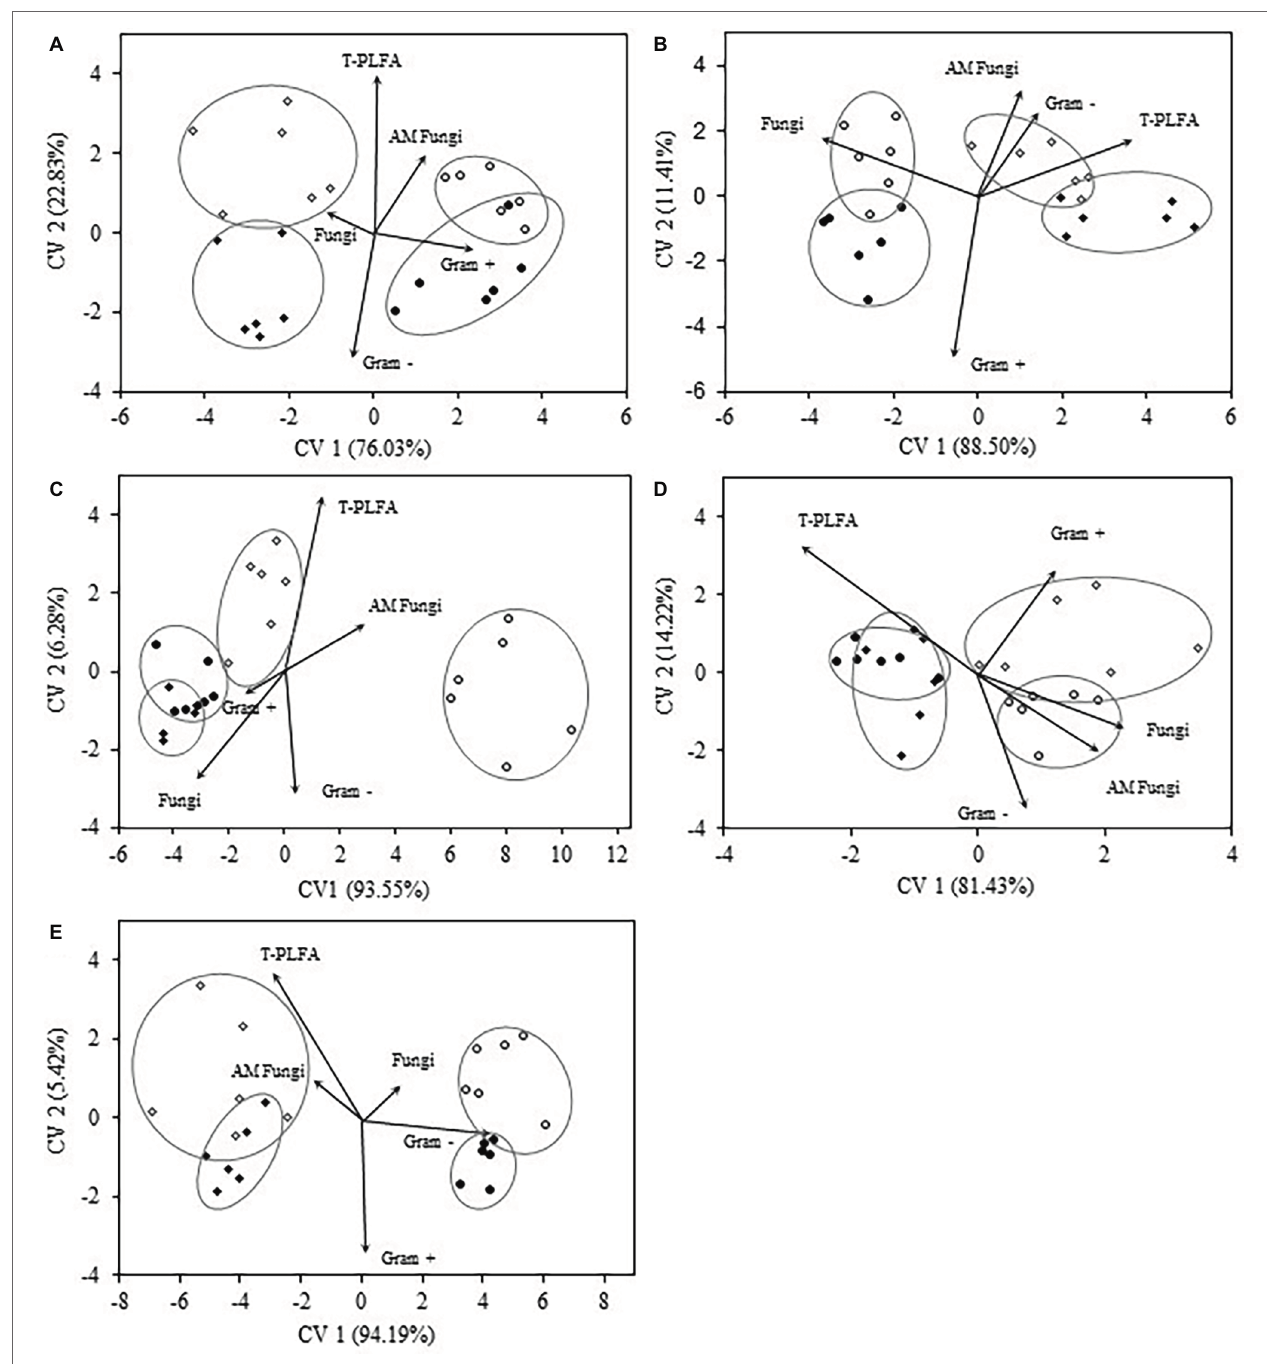
FIGURE 3 | Canonical variates for lipid biomarker groups. Biomarker groups and total PLFA (T-PLFA) of the 0–5 cm depth for crop years 2009 (A) , 2010 (B) , 2012 (C) , 2013 (D) , and 2014 (E) . Vectors represent standardized canonical coefficients and indicate the contribution of each biomarker group to each canonical variate. Each sample point is represented and cluster by crop treatment. Each cluster is accompanied by a mean ellipse at the 95% confidence interval (treatments groups that differ significantly have confidence ellipses that do not